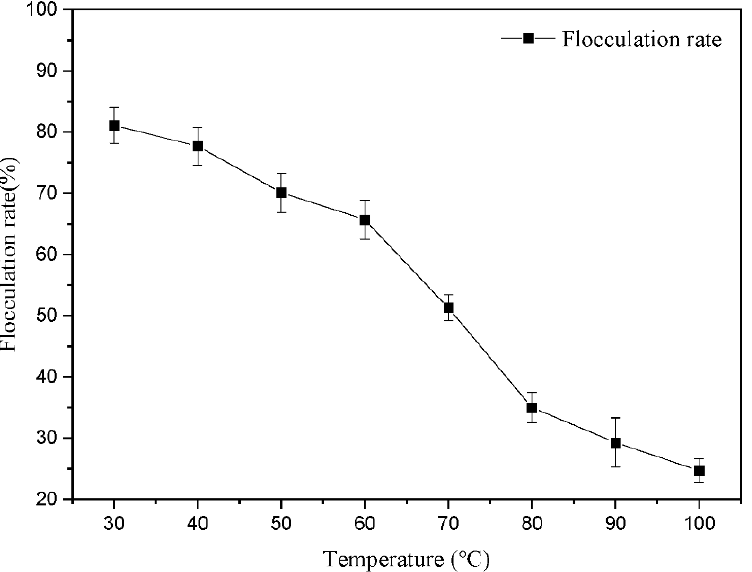
Figure 10. The effects of temperature on the FS stability. Error bars show standard errors among triplicate observations.